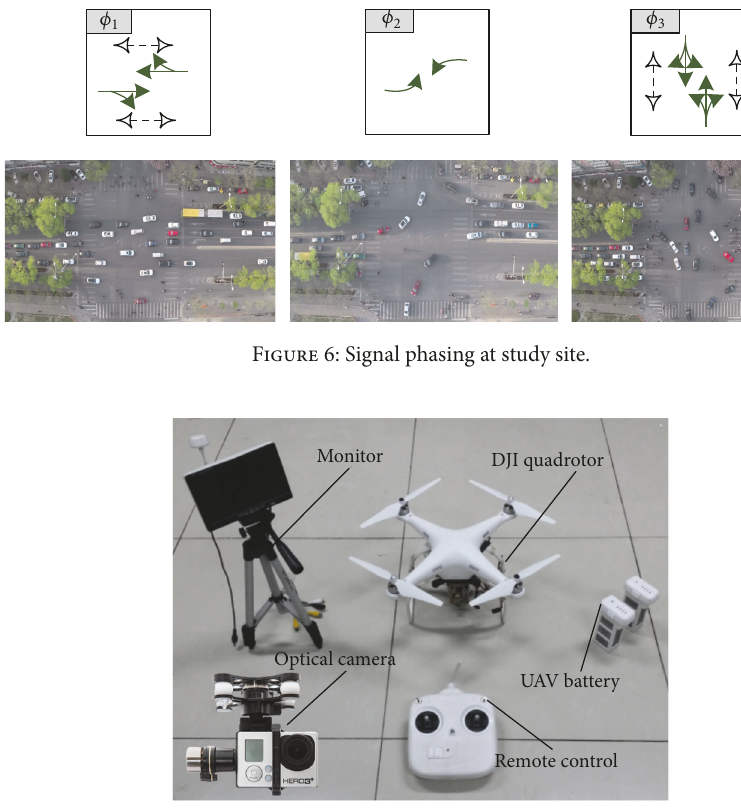
Figure 7: Quadrotor UAV for video collection.